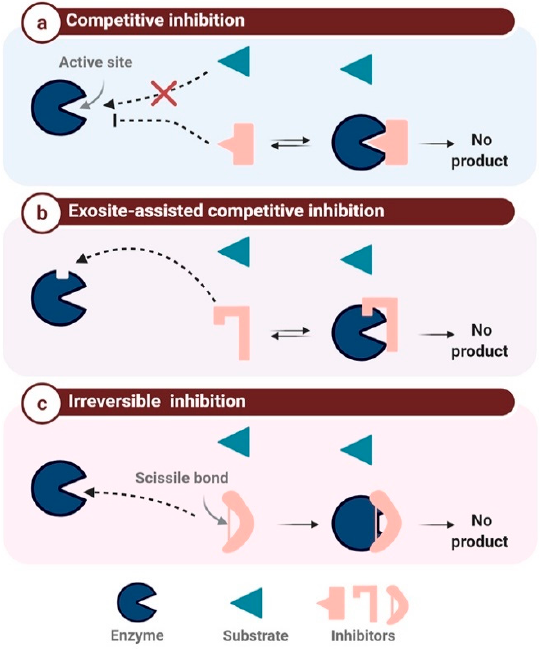
Figure 2. The mechanism-based classification of protease inhibitors. ( a ): competitive inhibition: the inhibitor binds to the active site instead of the substrate, ( b ): Exosite-assisted competitive inhibition: the inhibitor blocks the access to the active site through binding to an exosite, ( c ): Irreversible inhibition: the inhibitor binds irreversibly to the enzyme inducing its inactivation